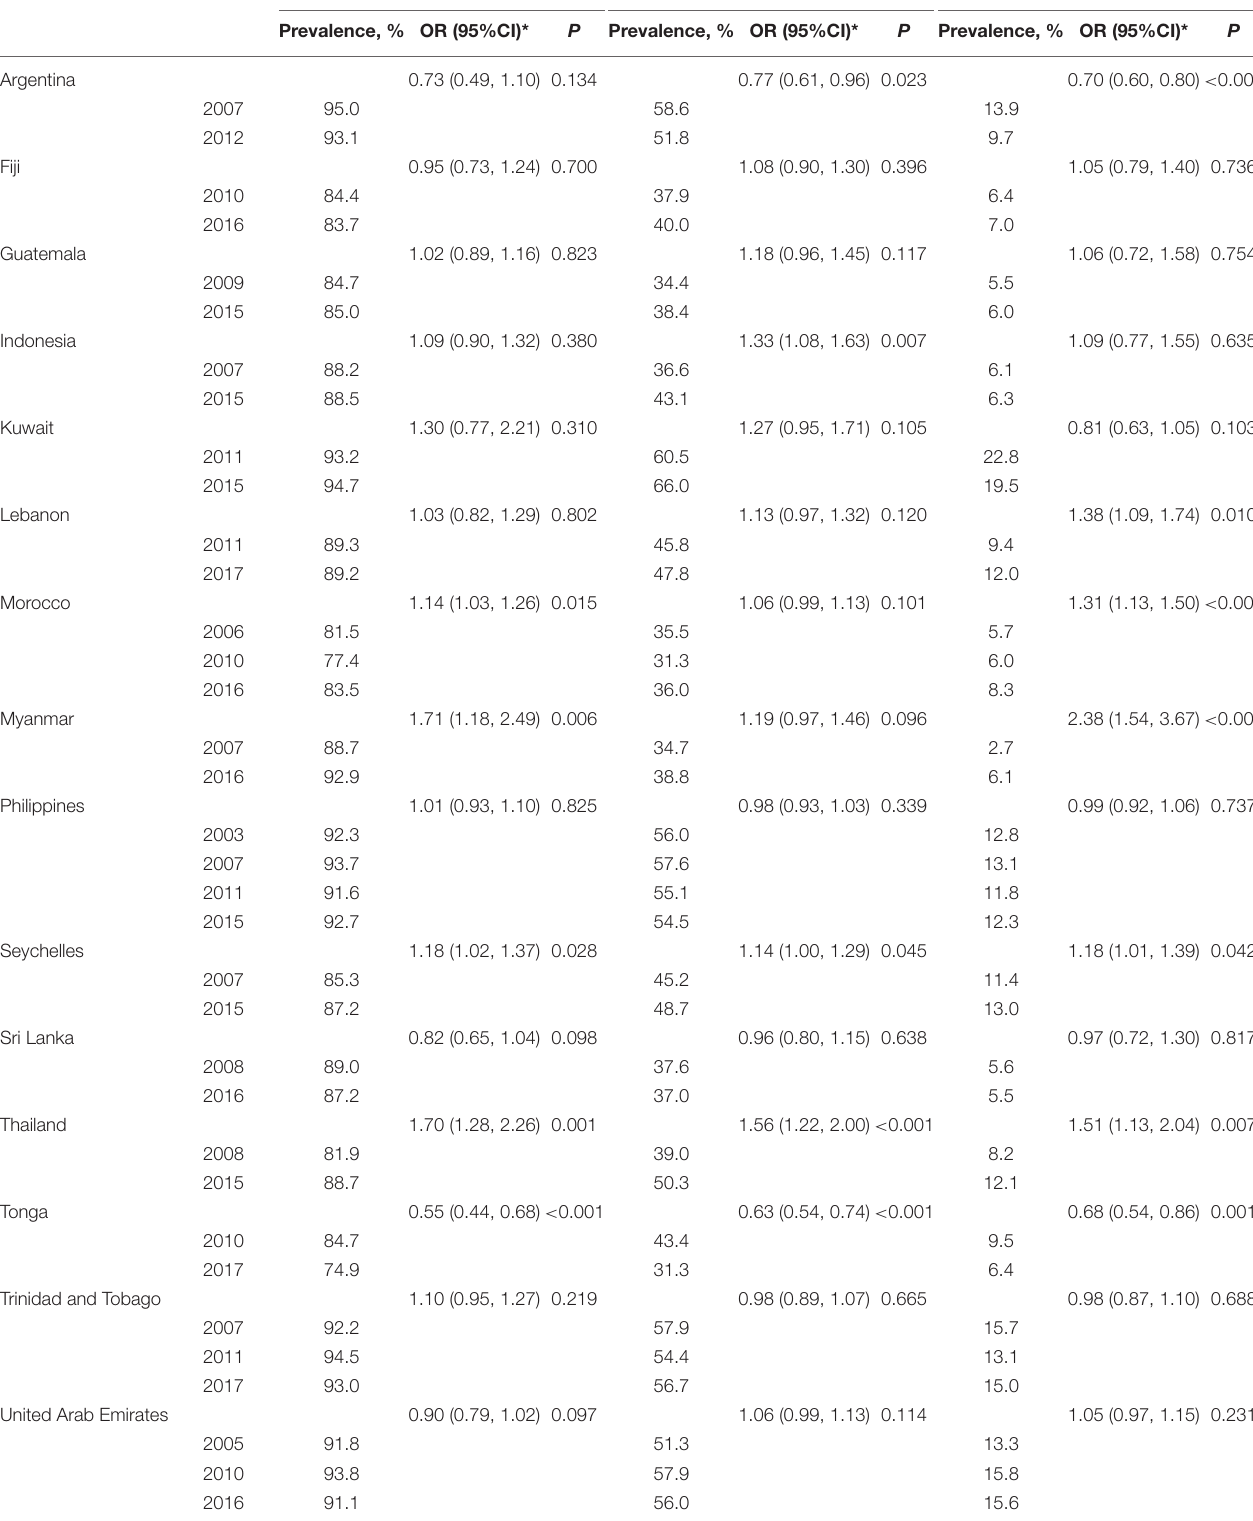
TABLE 3 | Prevalence of the co-existence of obesogenic behaviors and their trends in 15 countries across survey years.